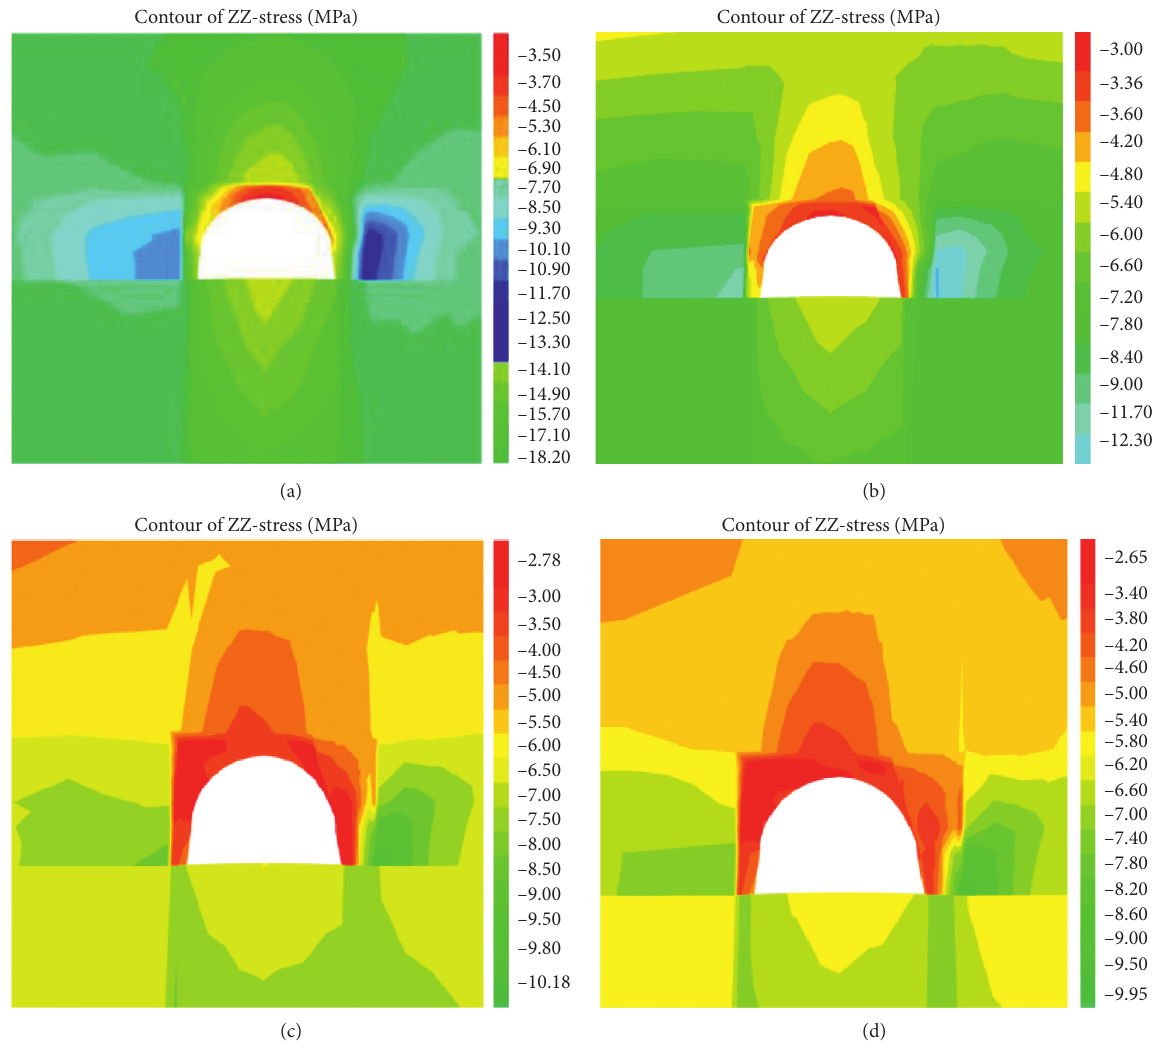
Figure 13: Stress change diagram of the surrounding rock after reinforcement: (a) working face advancing 12m, (b) working face advancing 36m, (c) working face advancing 60m, and (d) working face advancing